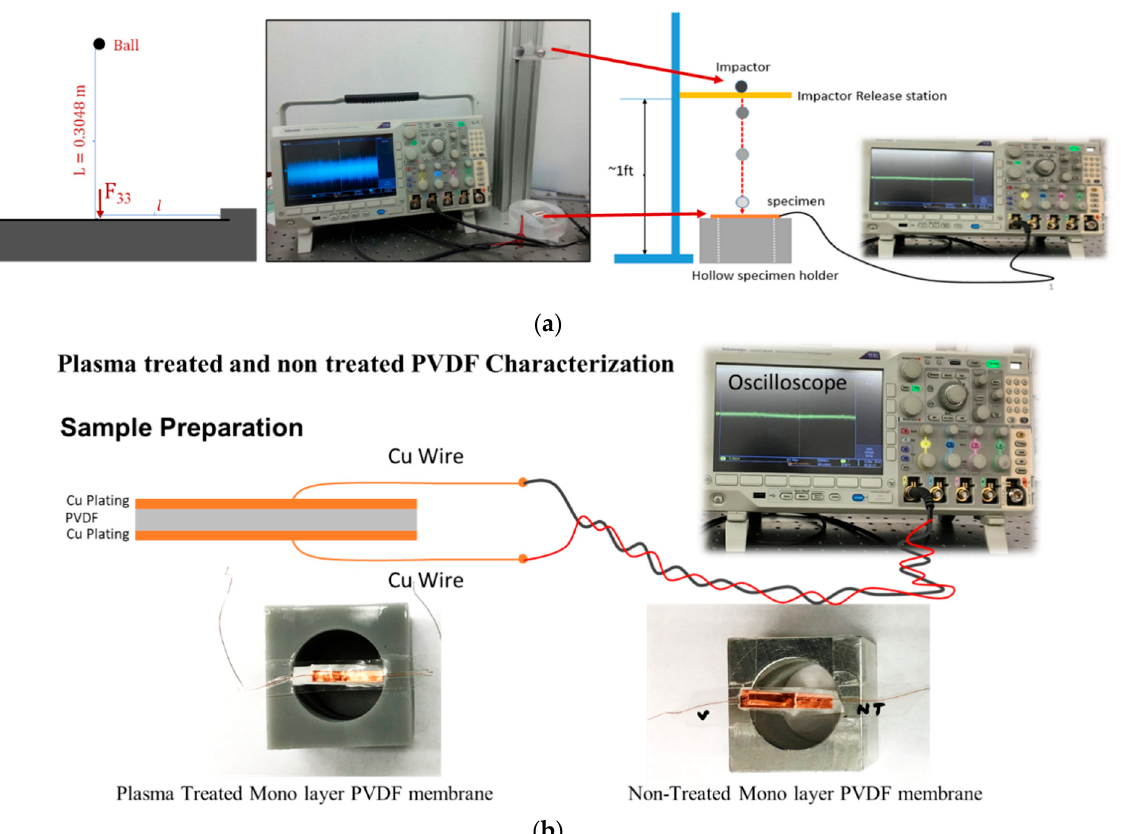
Figure 3. Experimental setup for evaluation of the fabricated sensors. ( a ) Schematic of the impact test and specimen with oscilloscope connection setup ( b ) Schematic of the prepared sample for the test, oscilloscope connection, and images of two-type prepared samples (plasma treated vs base PVDF).